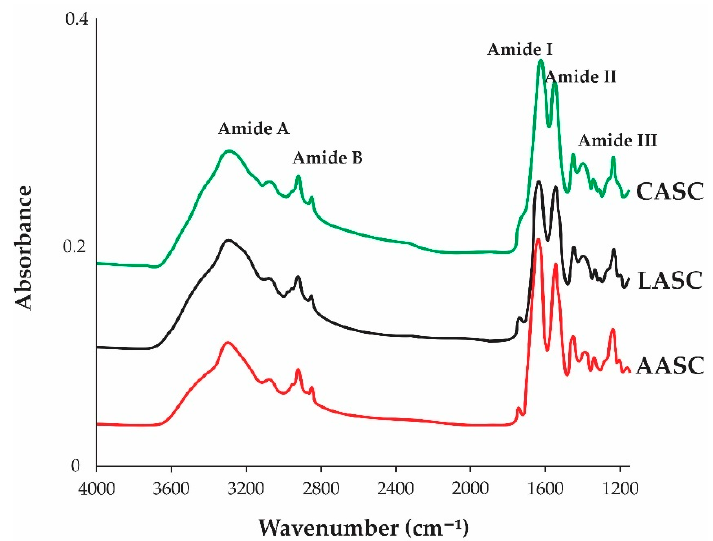
Figure 3. IR spectra of acid soluble unicornfish ( N. reticulatus ) bone collagen. AASC: acetic acid soluble collagen; LASC: lactic acid soluble collagen; CASC: citric acid soluble collagen. Table 2. The peak area and the description for the acid soluble unicornfish ( N. reticulatus ) bone collagen. Peak Location LASC